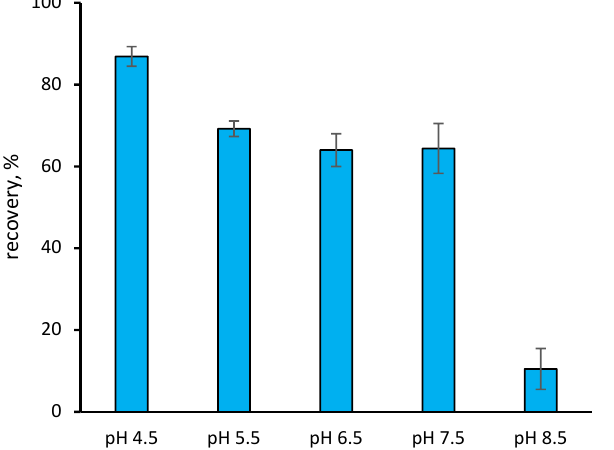
Figure 2. Effect of pH on loading of 1 mL of synthetic urine containing 200 ng mL − 1 of ciprofloxacin, diluted 9 + 1 v / v with 50 mmol L − 1 buffers.